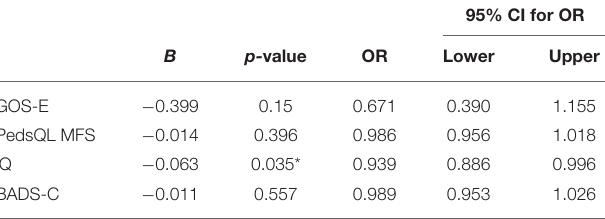
TABLE 5 | Logistic regression predicting likelihood of aid from